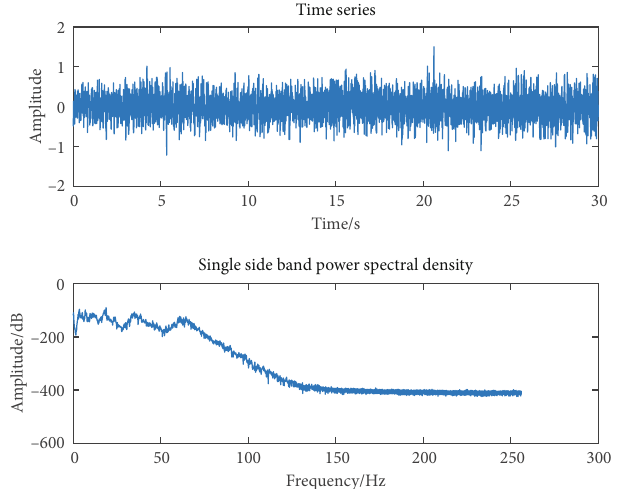
Figure 20: Time series and PSD of the wing in CH2.